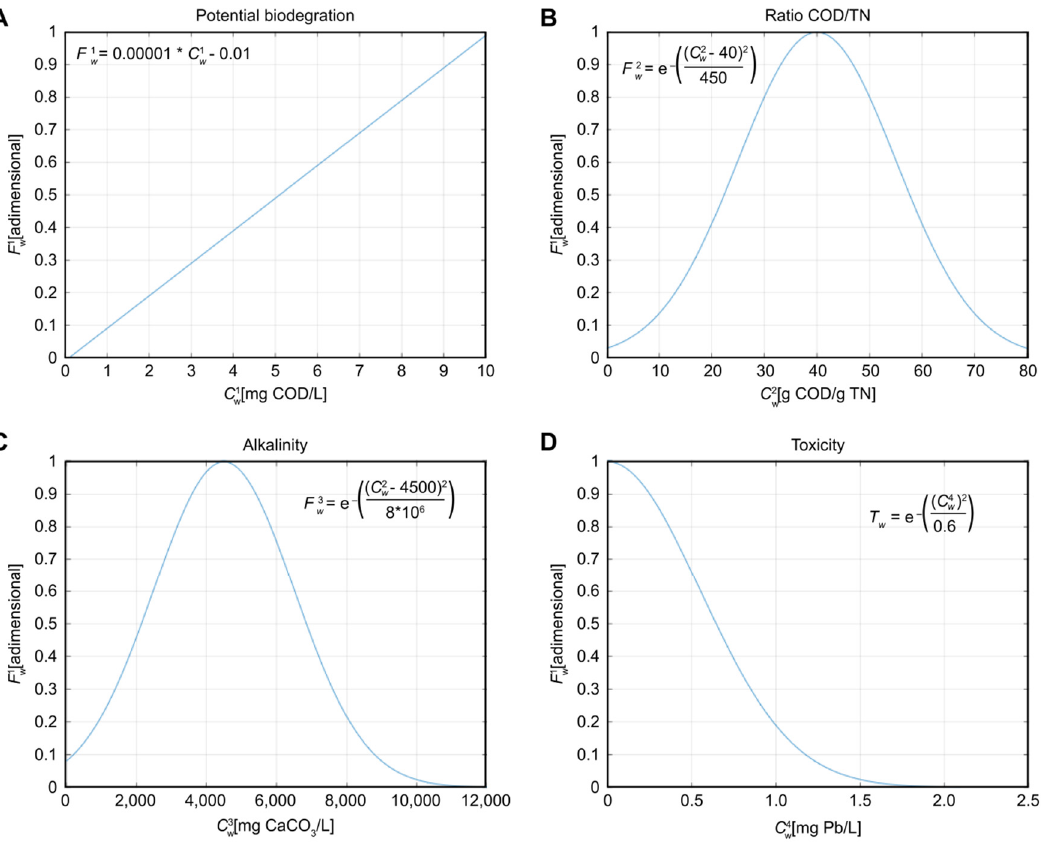
Figure 2. ( A ) F 1 w , ( B ) F 2 w , ( C ) F 3 w and ( D ) T w equations used for dimensionless coefficient